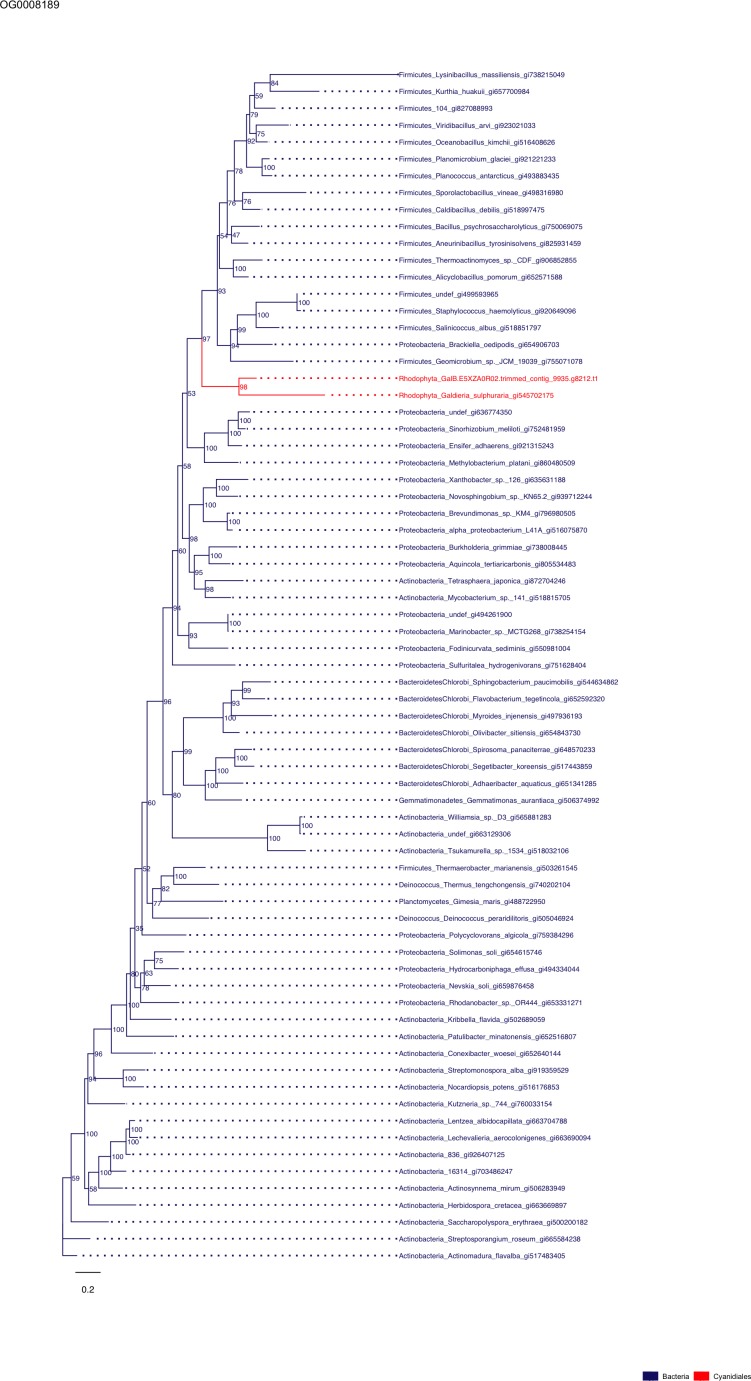
Sequence tree of orthogroup OG0008189.The tree is based on amino acid sequences. Archaea (yellow), Bacteria (blue), Cyanidiales (red), Eukaryotes including other red algae (green). Branches containing Cyanidiales sequences are highlited in red.